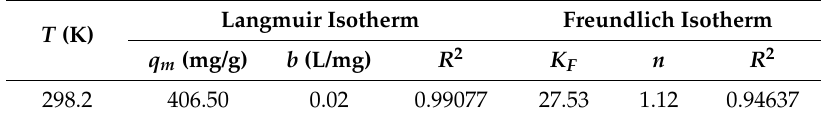
Table 3. Langmuir and Freundlich model parameters for Pb(II) loaded onto MIL-125-CS beads. T (K)